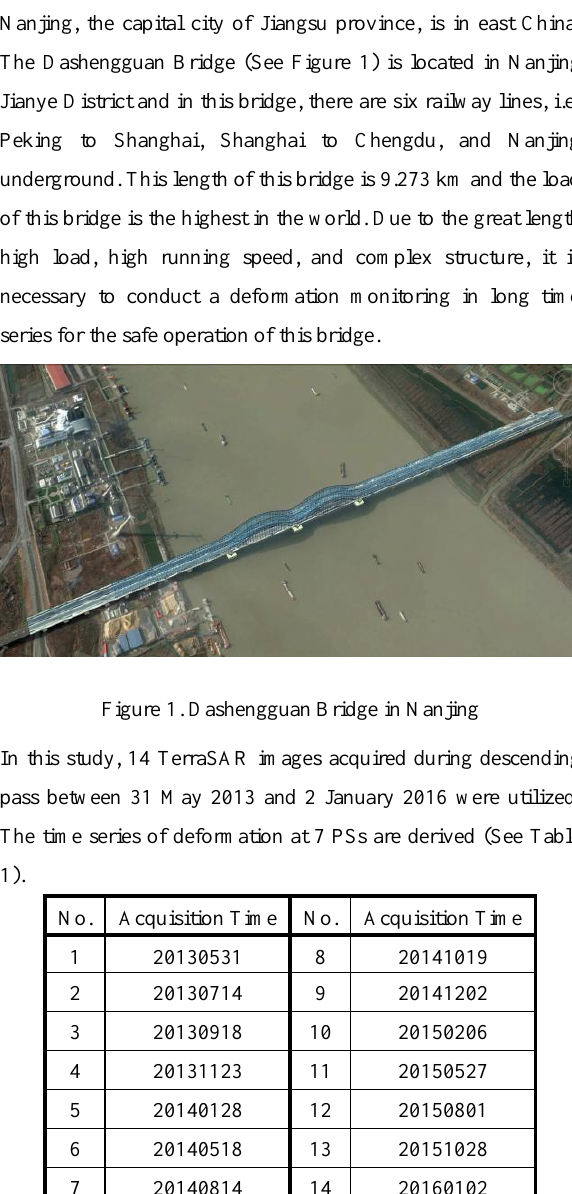
Table 1. Acquisition Time of 14 TSX images